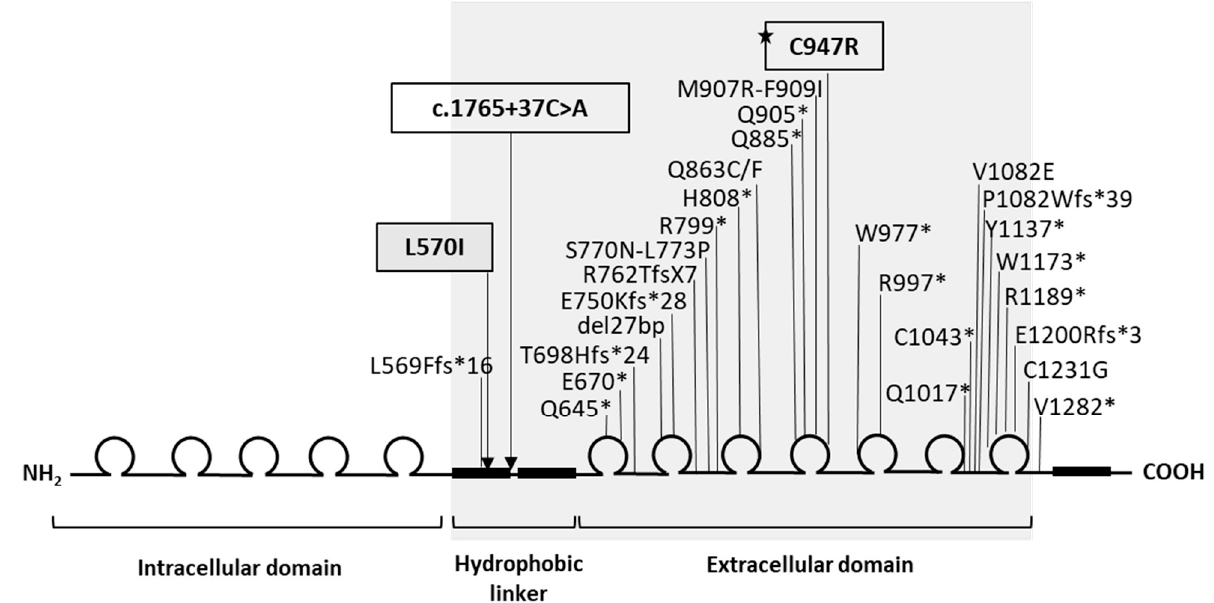
Figure 1. Schematic representation of IGSF1 protein domain structure and the relative locations of the mutations identified in this study and previously reported pathogenic mutations. The two novel variants (p.L570I and c.1765+37C>A) are framed in black. The pathogenic variant is labeled with ( ★ ). Region screened in this study (grey).